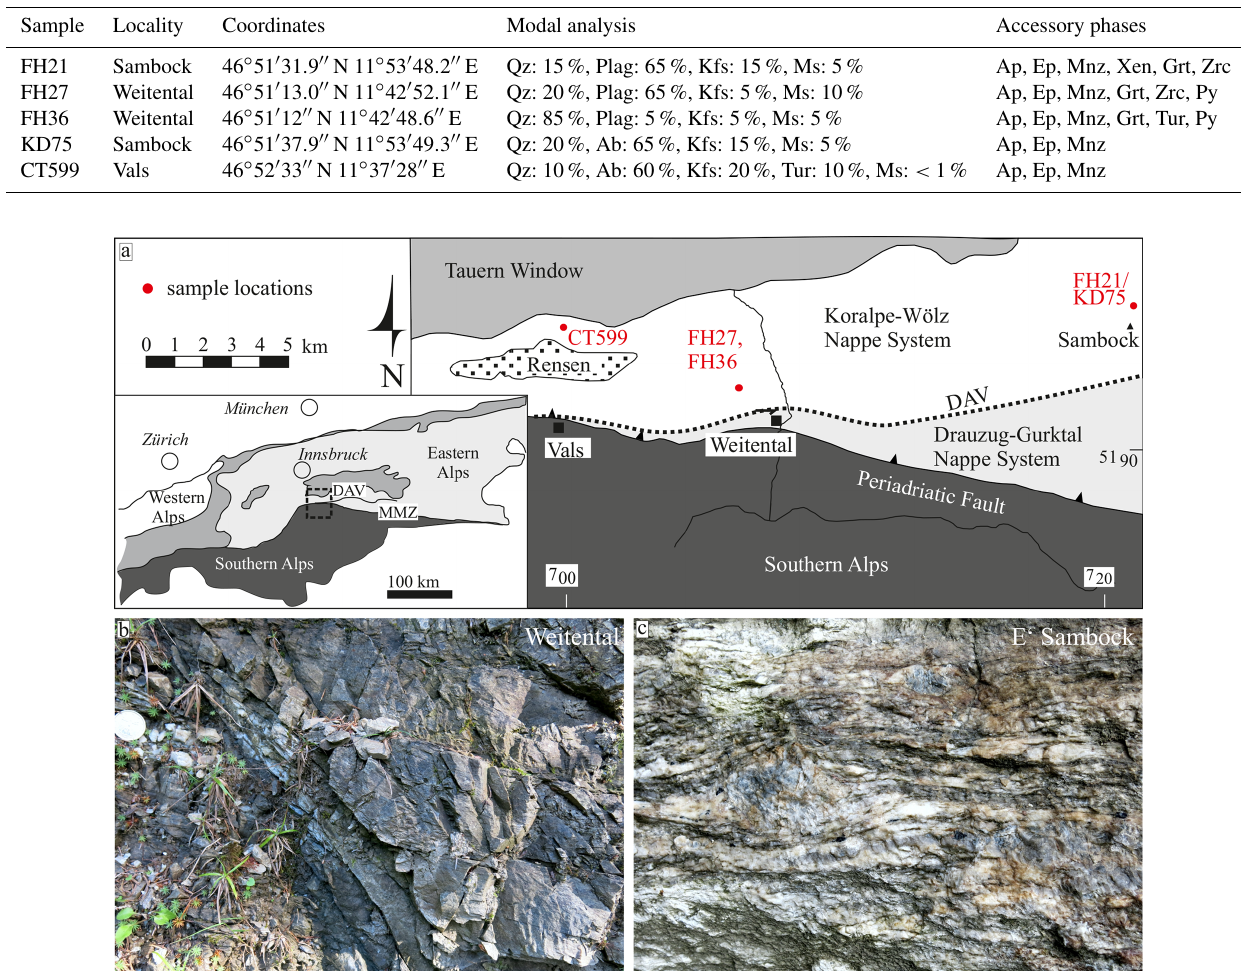
Table 1. Overview of the presented samples.